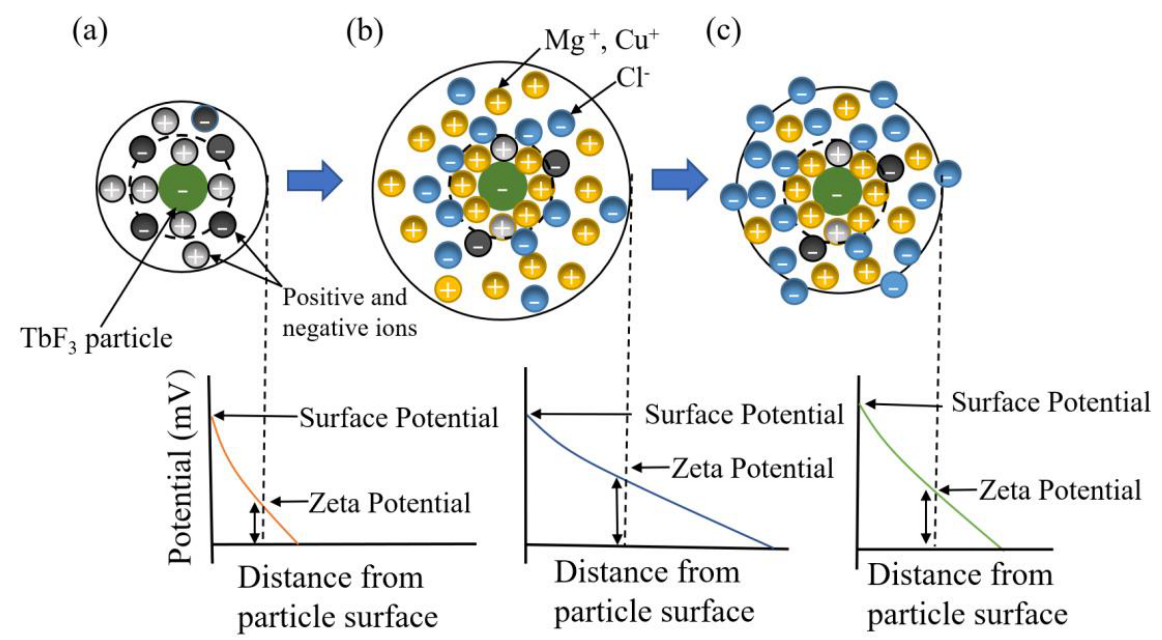
Figure 7. Schematic of the diffusion electric double layer region of a TbF 3 particle. ( a ) Without charging agents; ( b ) with low content of charging agents; ( c ) with excess content of charging agents.